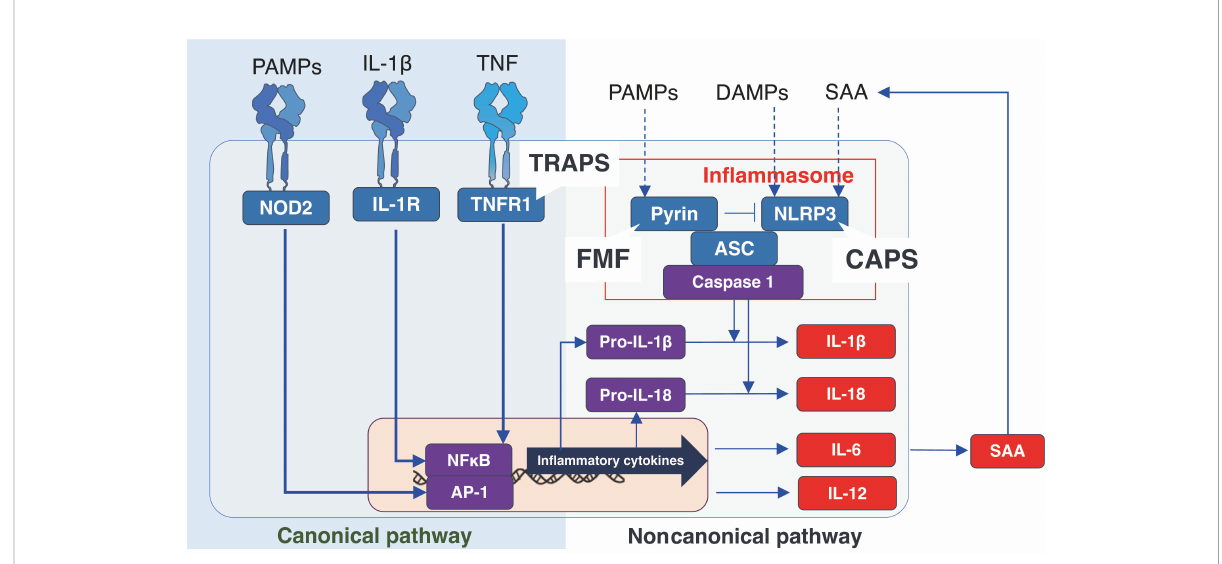
FIGURE 2 The cytokine network in familial Mediterranean fever. CXCL10: interferon gamma-inducible protein 10, G-CSF, granulocyte-colony stimulating factor; ICAM-1, intercellular adhesion molecule 1; IFN- g , interferon- g ; IL, interleukin; TNF, tumor necrosis